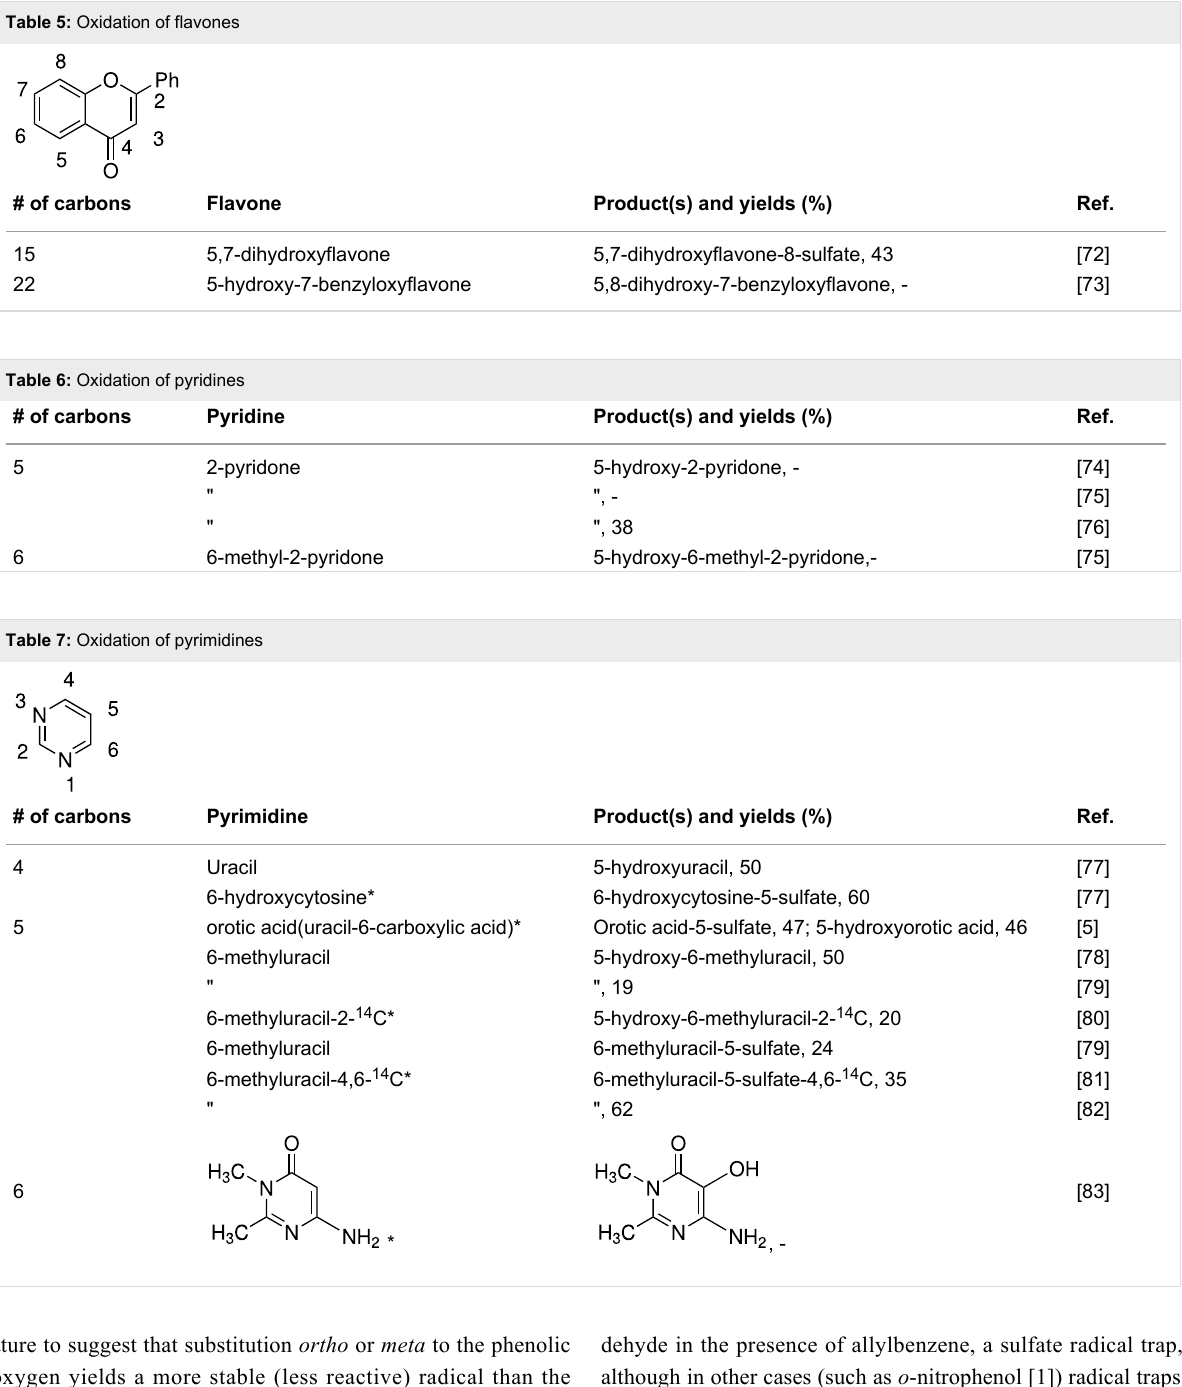
Table 5: Oxidation of flavones